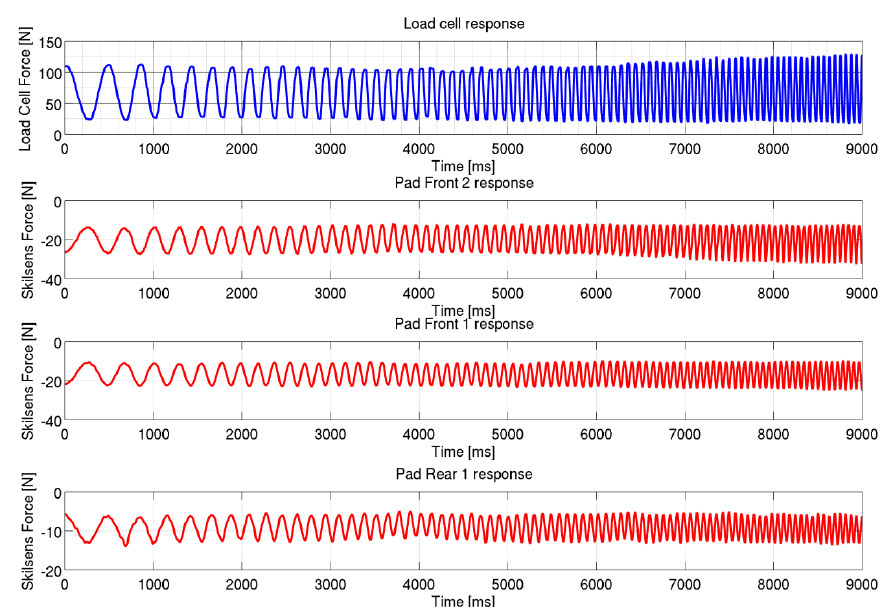
Figure 11. Dynamic characterization results: Force acting on the three pads, compared with the force recorded by the load